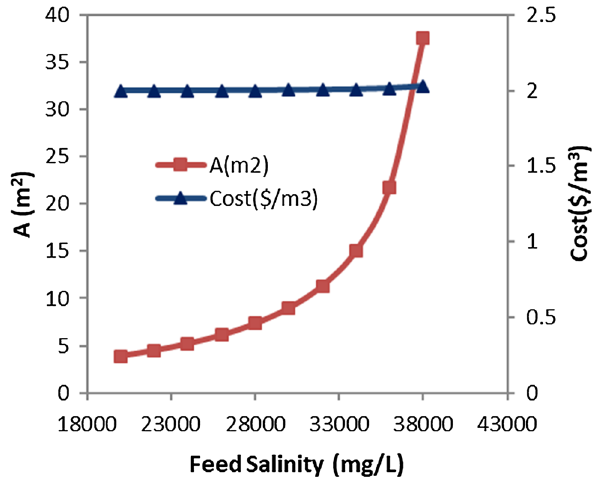
Fig. 7 Modeling the changes of the feed water salinity versus cost and the active area of the